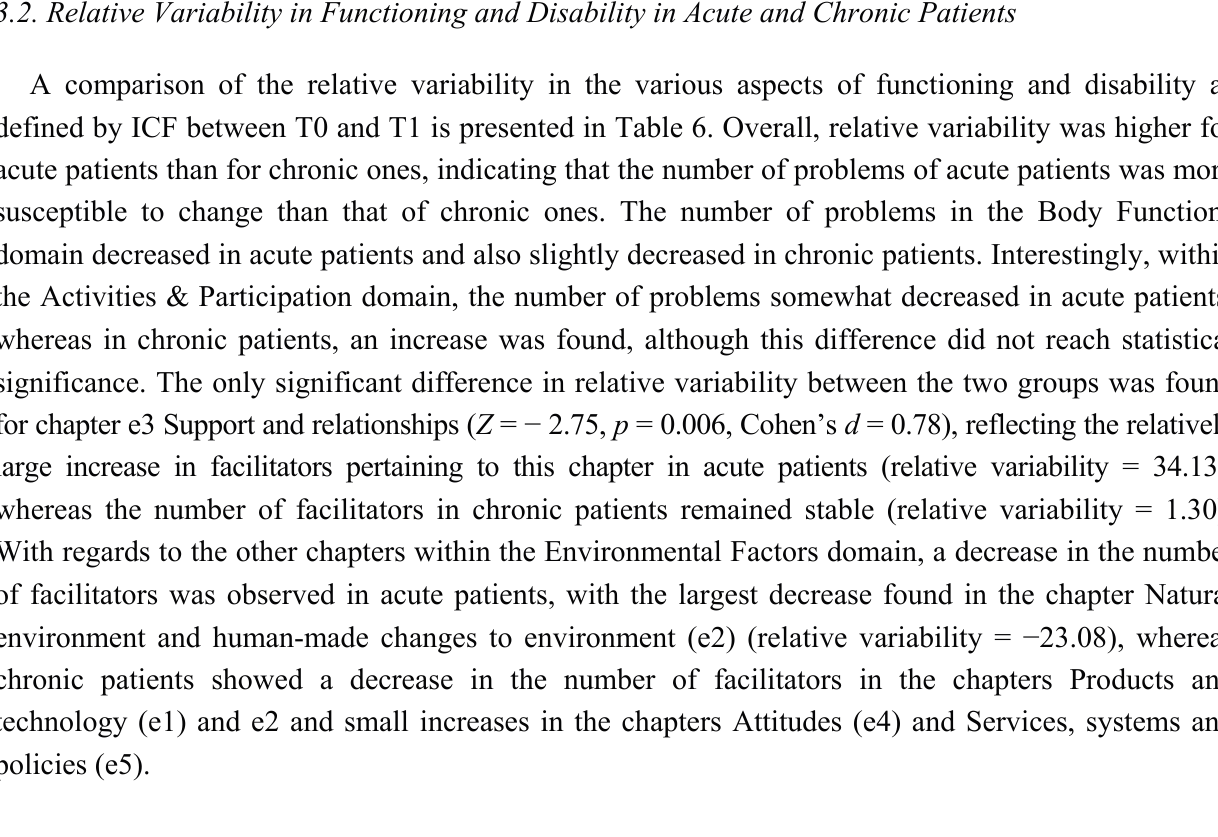
Figure 3. Comparison of the percentage of patients who improved or deteriorated on the various International Classification of Functioning, Disability, and Health domains with respect to the number of severe or complete problems (severity index) between T0 and T1. The number of problems of the remaining patients did not